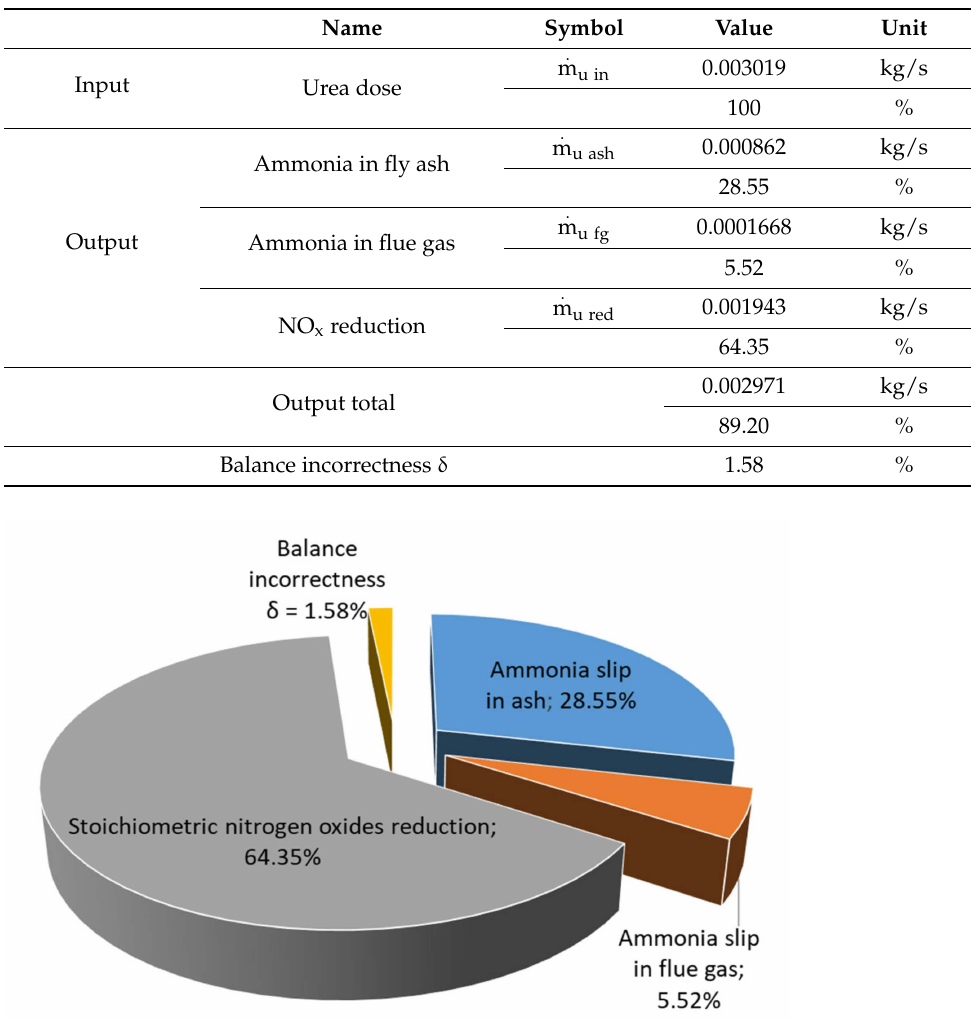
Table 6. Mass balance of ammonium compounds in the FJBS+ process.